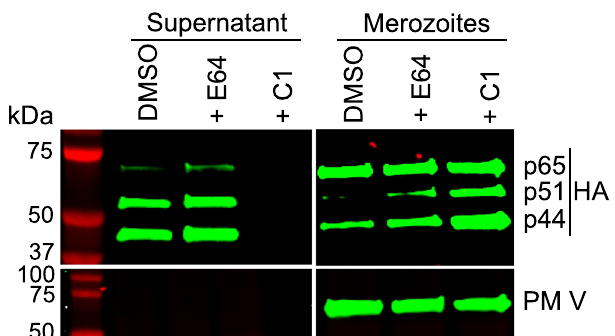
Fig.6|PMXisprocessedinterminalsecretorycompartmentsintheparasites. Synchronized 40 – 43h schizonts expressing PM X-3xHA were treated separately with the vehicle (DMSO), E64d (10 μ M) and C1 (1.5 μ M) for 8h. Samples were fractionated to separate the secreted (supernatant) components from those that remained intracellular (merozoites). PM X-3xHA was pulled down using anti-HA antibody.WesternblotwasdonewithbothfractionstoassessdistributionofPMX. AliquotswereblottedforPMVasanintracellularcontrol.Shownarerepresentative blots from two independent experiments. Source data are provided as a Source Data fi